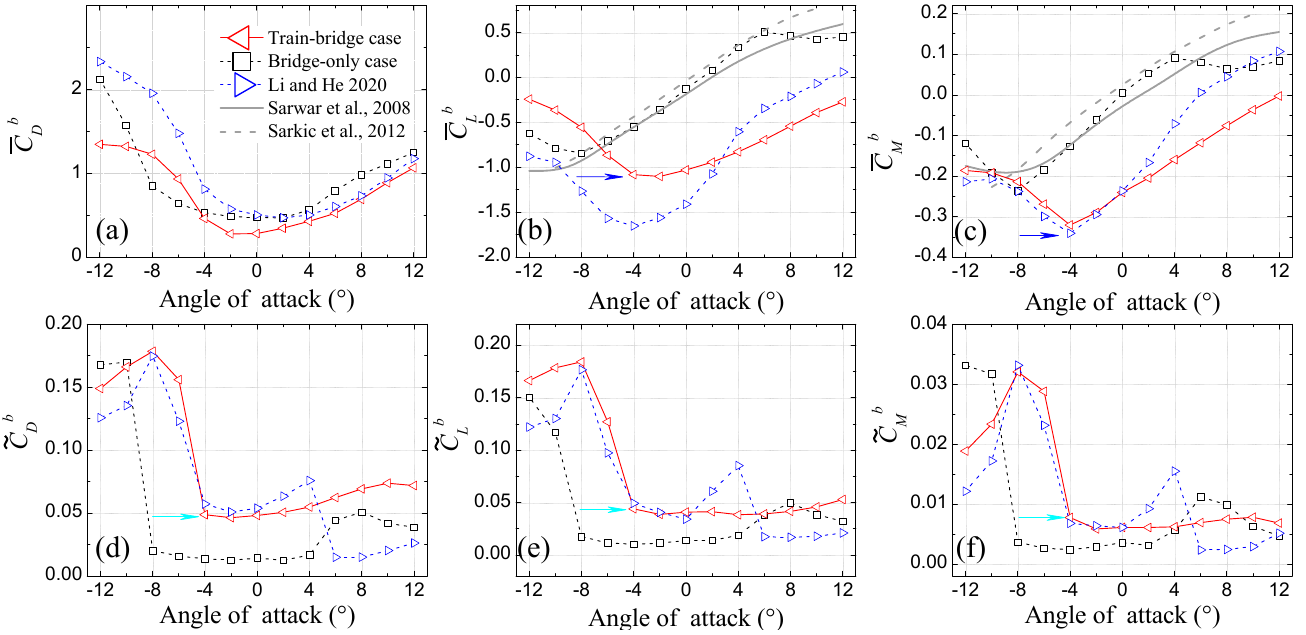
Figure 9. Aerodynamic force coefficients of the bridge-deck model: ( a ) Mean drag coefficients; ( b ) Mean lift coefficients; ( c ) Mean moment coefficients; ( d ) Fluctuating drag coefficients; ( e ) Fluctuat- ing lift coefficients; and ( f ) Fluctuating moment coefficients.